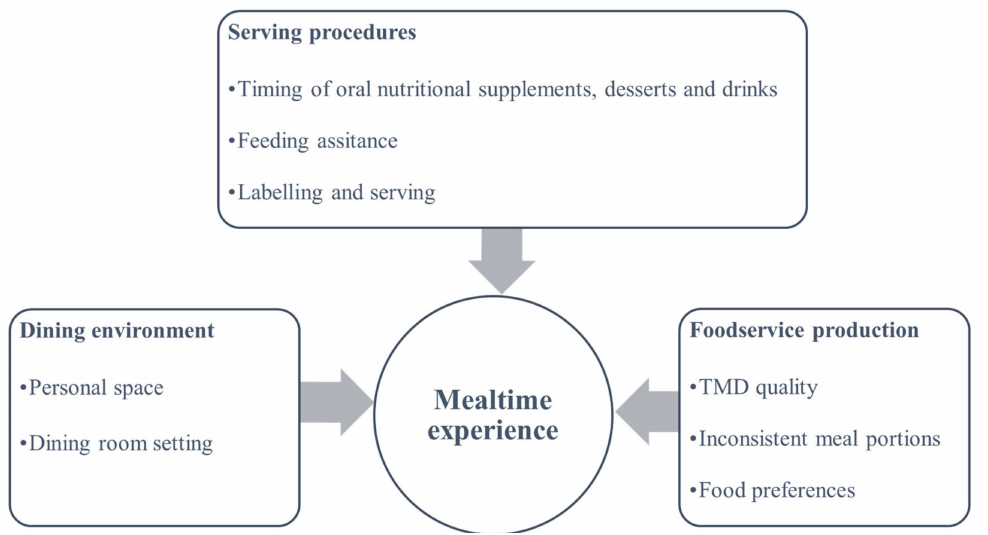
Figure 2. Final conceptual diagram demonstrating the three main themes and eight subthemes associated with mealtime